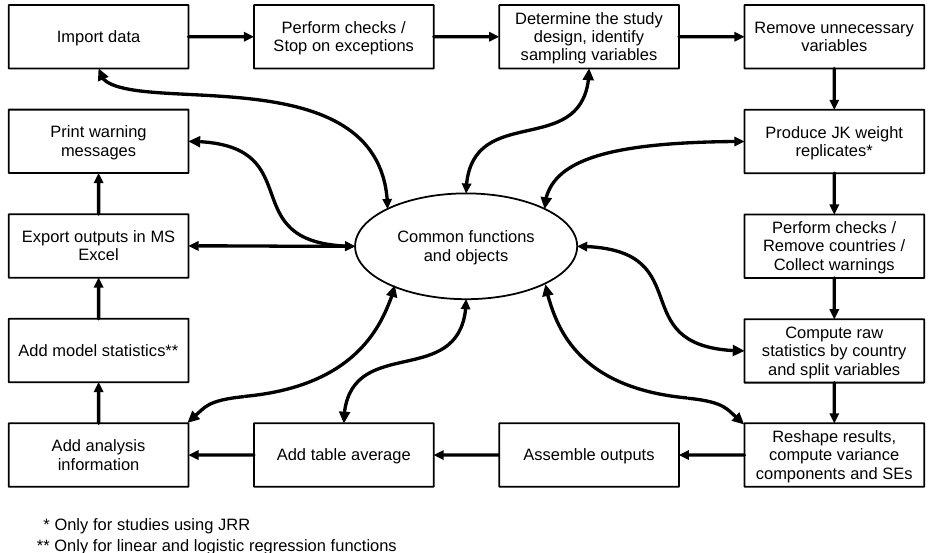
Figure 1. Structure and workflow of an analysis